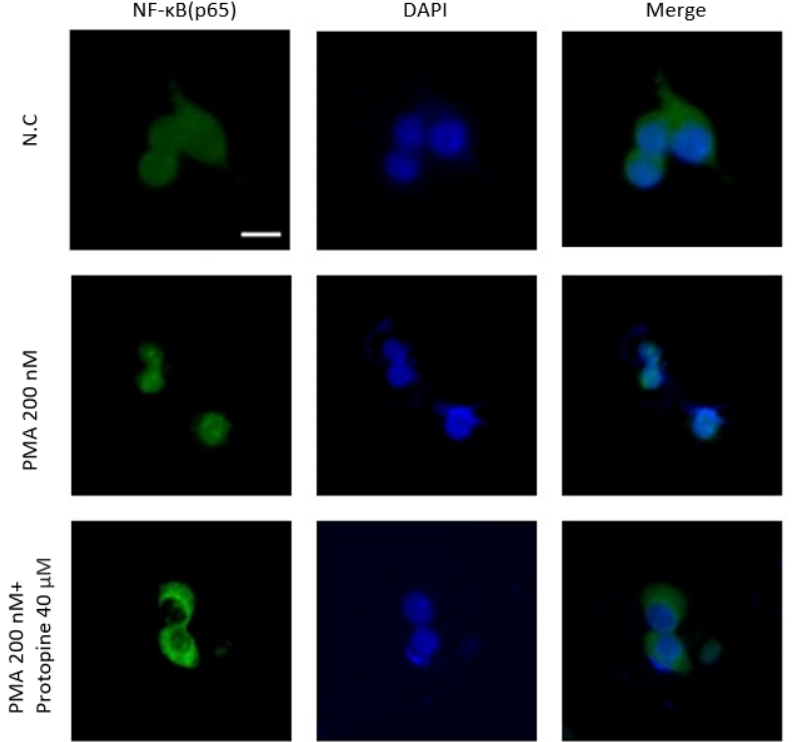
Figure 2. Protopine regulated NF- κ B translocation in PMA-stimulated HepG2 cells. ( A ) Protopine treatment induced nuclear NF- κ B expression in a concentration-dependent manner. ( B ) Protopine treatment induced cytosol NF- κ B expression in a concentration-dependent manner. Results are presented as means ± SD. # p < 0.05 and ## p < 0.01 indicates significantly different from control group. * p < 0.05, ** p < 0.01 indicate significantly different from PMA group. NC, normal control group; IND, inducer.